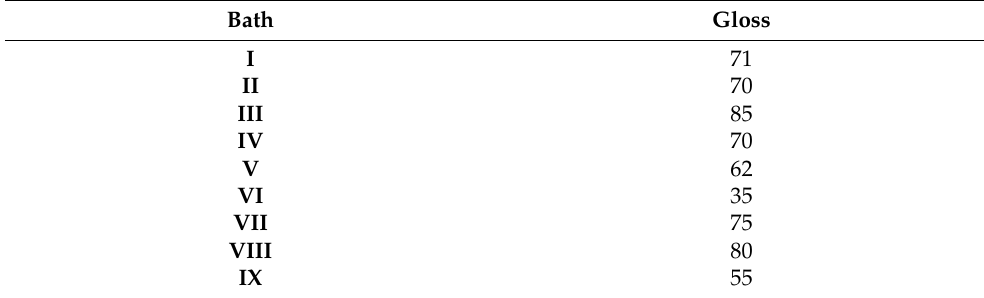
Table 2. Average gloss values of Hull cell deposits produced between 215 and 325 A m − 2 . Bath